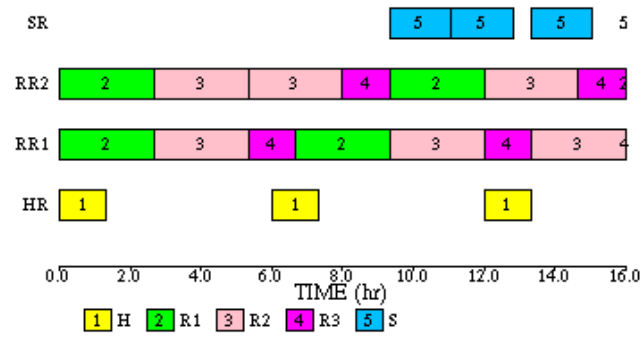
Figure 11. Example 4 Gantt chart.